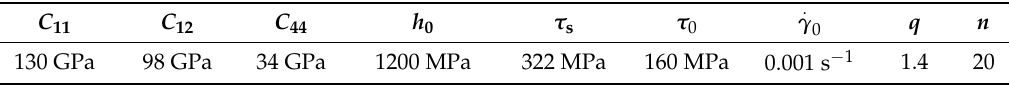
Table 1. Material parameters of as-received NiTi